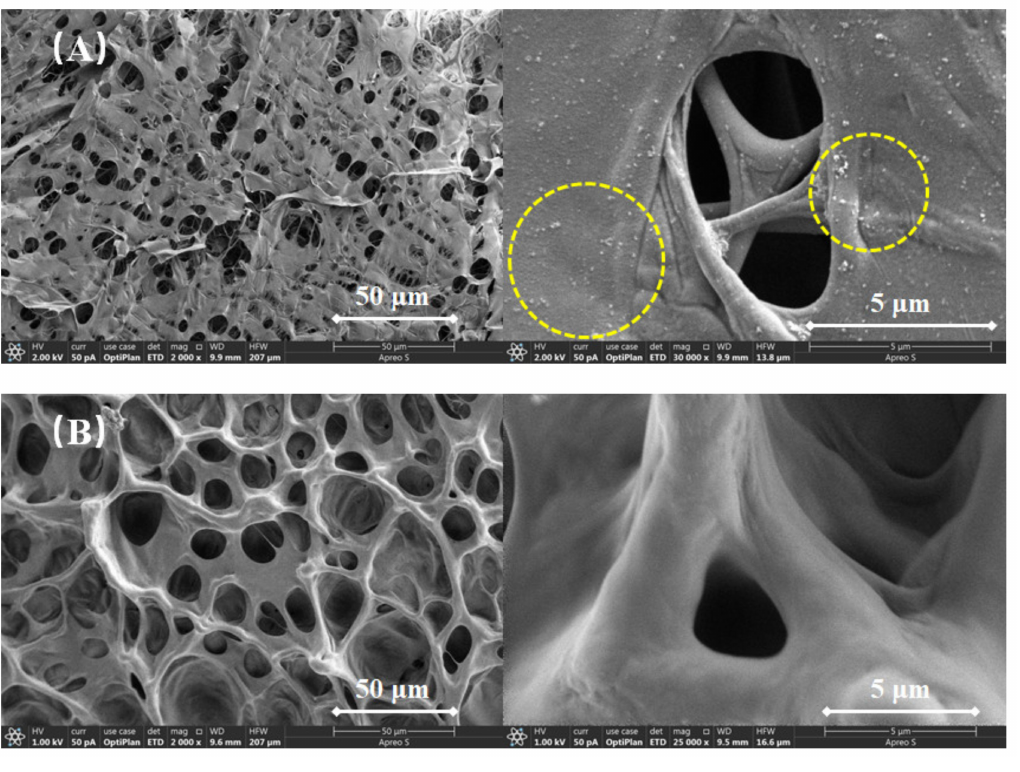
Figure 11. SEM images of ( A ) suspension diluent and ( B ) powder solution.